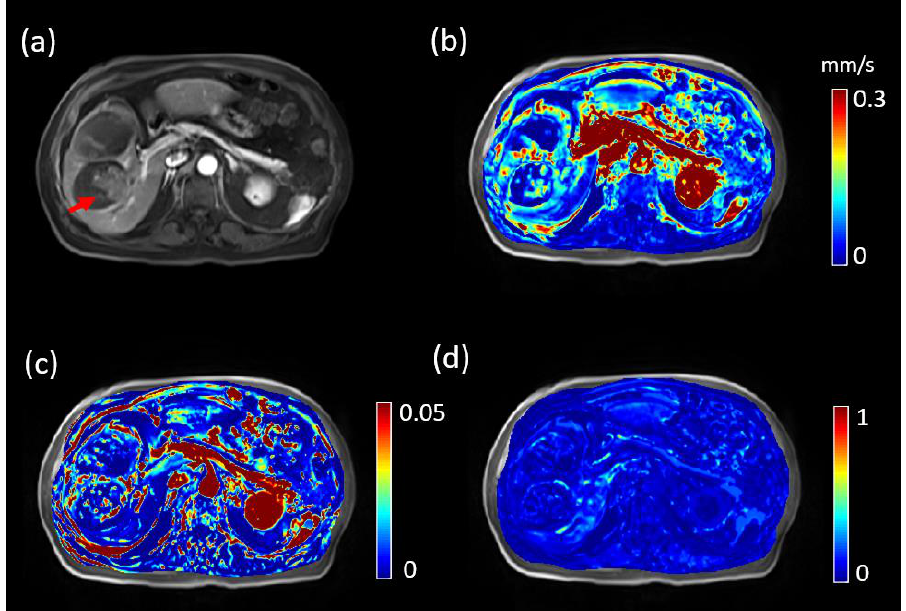
Figure 2. DCE MRI, QTM velocity, 𝐾 𝑡𝑟𝑎𝑛𝑠 and 𝑉 𝑒 maps of HCC of a 78-year-old patient with lung shunting fraction 15.3%. ( a ) post-Gd T1 weighted image showing the tumor (red arrow). ( b ) QTM |𝒖| map, ( c ) 𝐾 𝑡𝑟𝑎𝑛𝑠 map , and ( d ) 𝑉 𝑒 map.